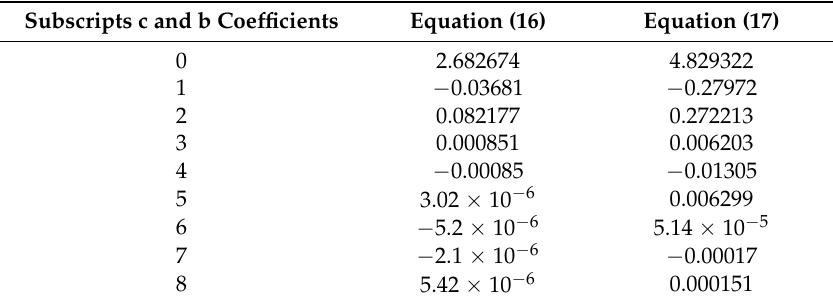
Table 3. The values of the polynomial coefficients of Equations (16) and